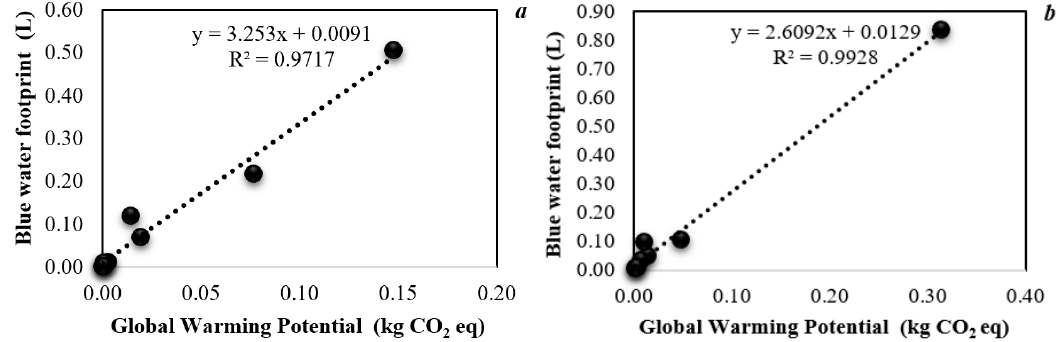
Figure 18. Correlation between global warming potential and indirect blue water footprint for ( a ) case study I and ( b ) case study II.